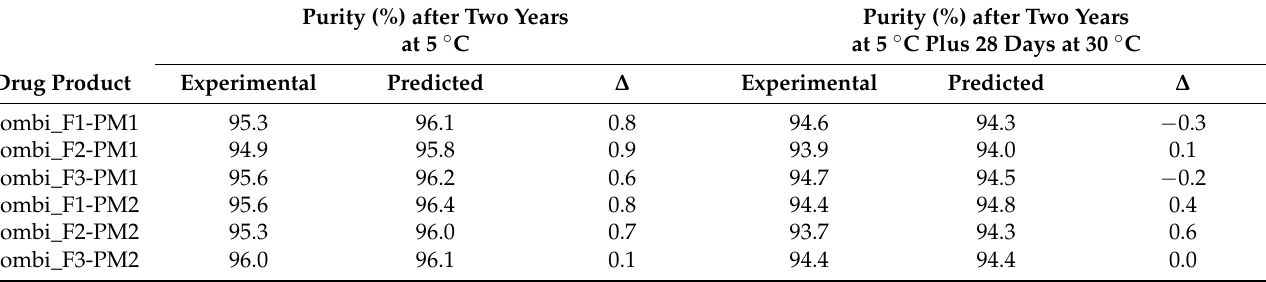
Table 4. Experimental vs. predicted values of peptide purity as measure for long-term chemical stability for three different peptide formulations in two different packaging materials combined into six drug products after storage for two years at 5 ◦ C and after a subsequent in-use period of 28 days at 30 ◦ C. The corresponding plots and rate equations are provided in Figure 2 and Equations (2)–(7). Purity (%) after Two